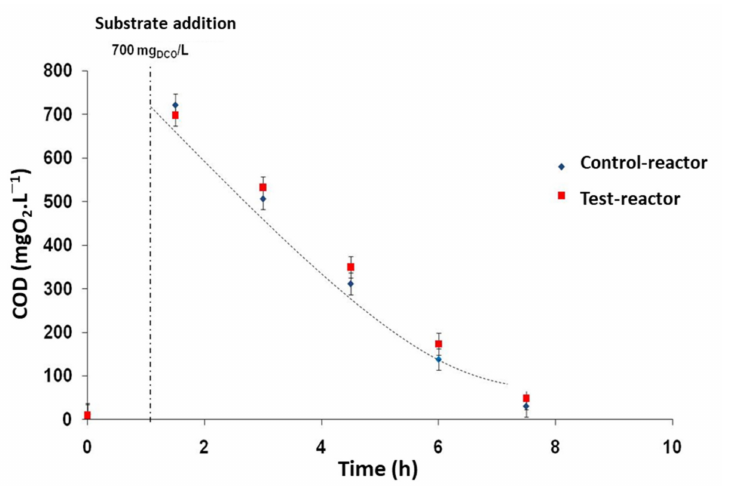
Figure 3. Evolution of the soluble COD concentration in the reactor exposed to a TBT concentration of 600 ng Sn · L − 1 and in the control